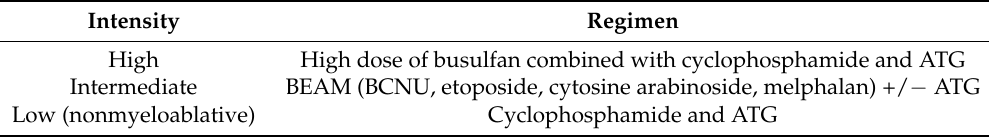
Table 1. Immunoablation regimens.